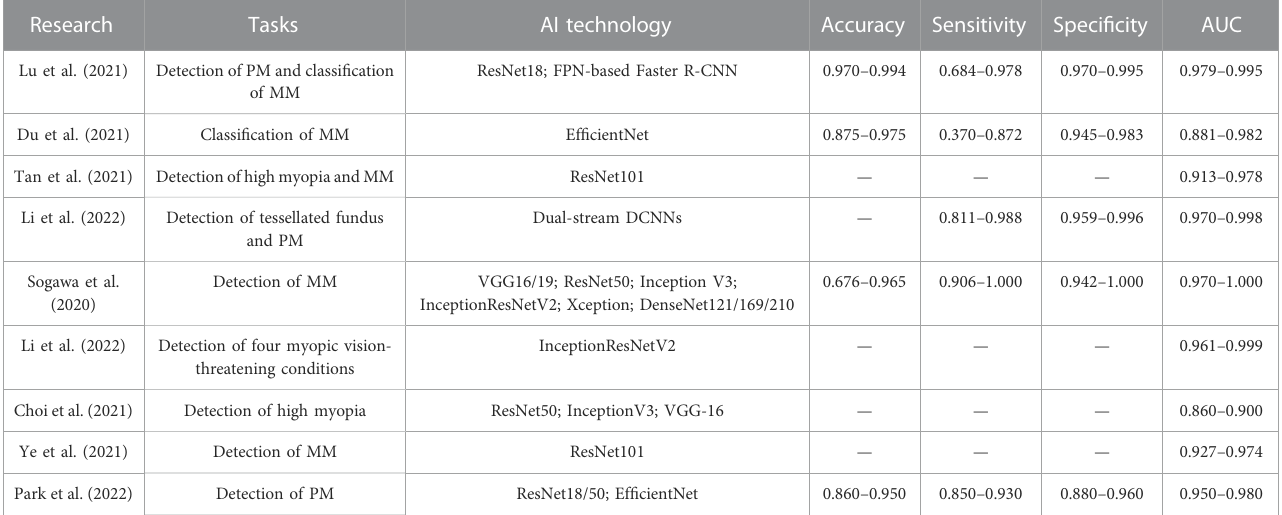
TABLE 2 Summary of DL methods for classi fi cation tasks in myopia.